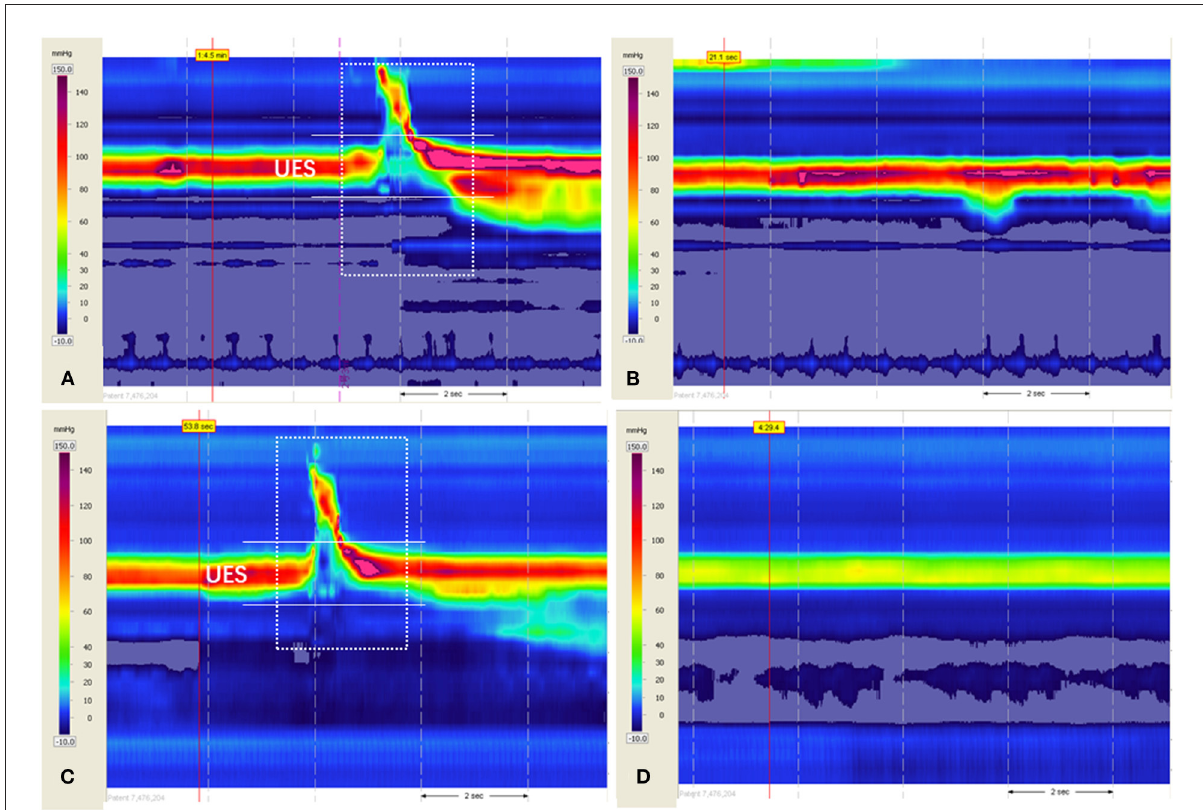
FIGURE1 A space–time diagram of high-resolution manometry before and after treatment. The x -axis represents time (dotted arrow indicates 2s), and the y -axis represents the distance from the nostril. Each pressure was assigned a color (legend, left). (A) When swallowing 3ml of thick liquid before treatment on April 6, 2021, the UES resting pressure and UES residual pressure increased, while the coordination of pharyngeal contraction and UES relaxation was normal. (B) Resting pressure in the resting state before treatment on April 6, 2021. (C) When swallowing 3ml of thick liquid after treatment on July 22, 2021, the UES resting pressure and UES residual pressure dropped to normal. (D) The resting pressure in the resting state after treatment on July 22, 2021, was a more straightforward indication of improvement. The white arrow indicates the UES residual pressure. The dotted box indicates swallowing. UES, upper esophageal